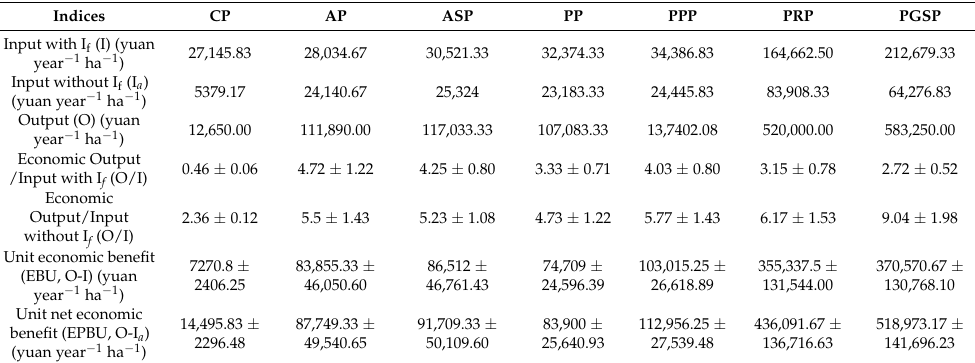
Table 5. Indices for the economic evaluation of the seven agroforestry planting